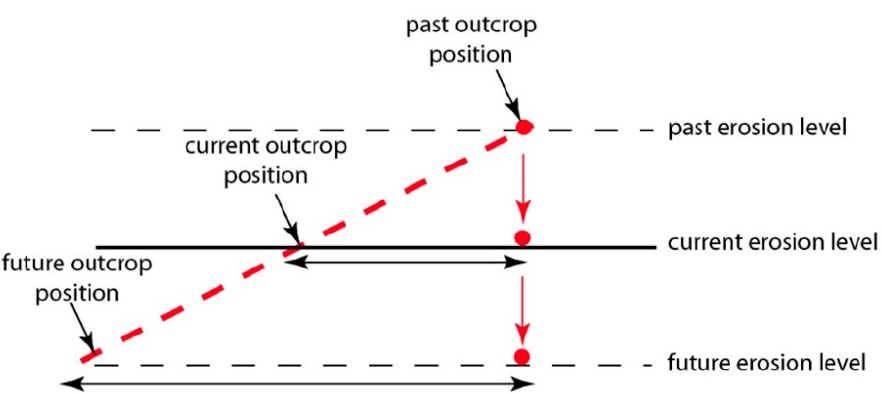
Figure 55. Schematic time-relationship of the formation and position of a colluvial placer through erosion of an angle-dipping primary deposit [25].